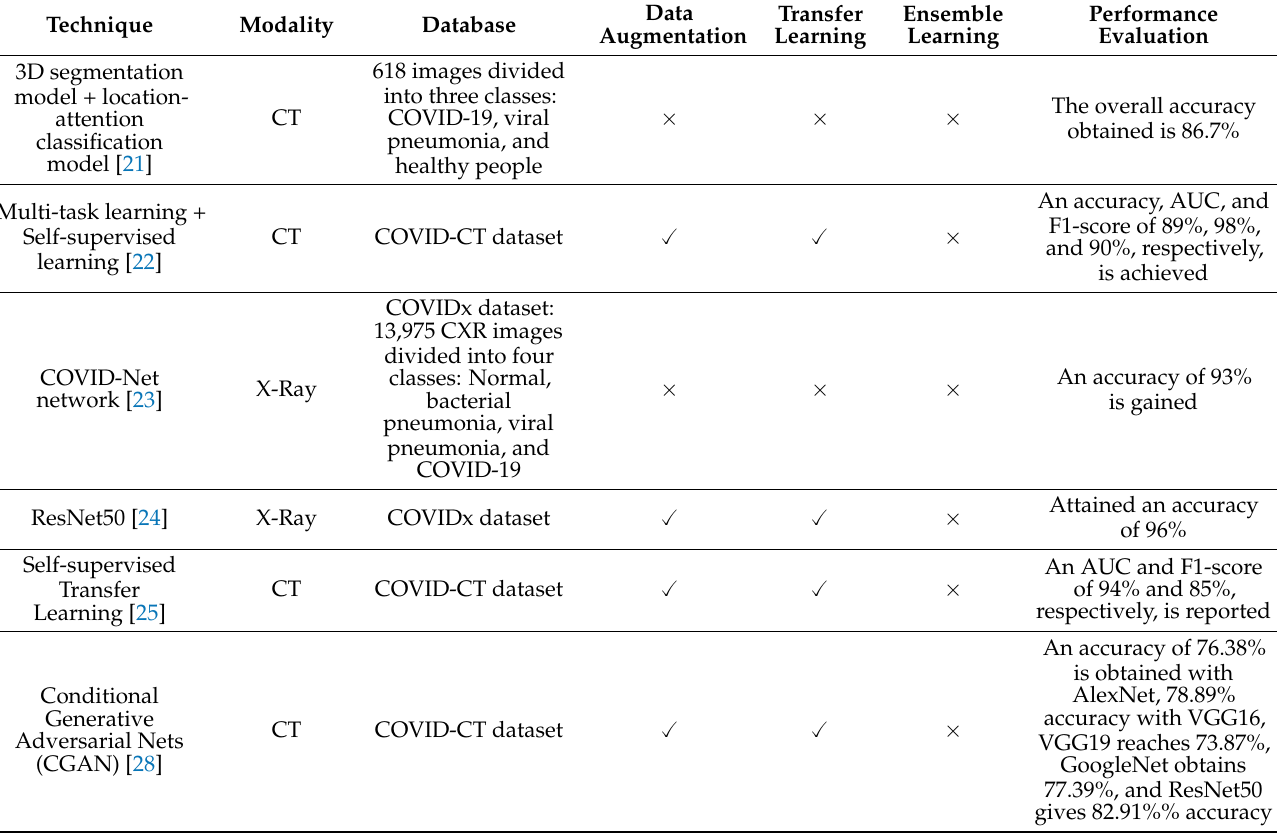
Table 1. A summary of the most recent COVID-19 detection